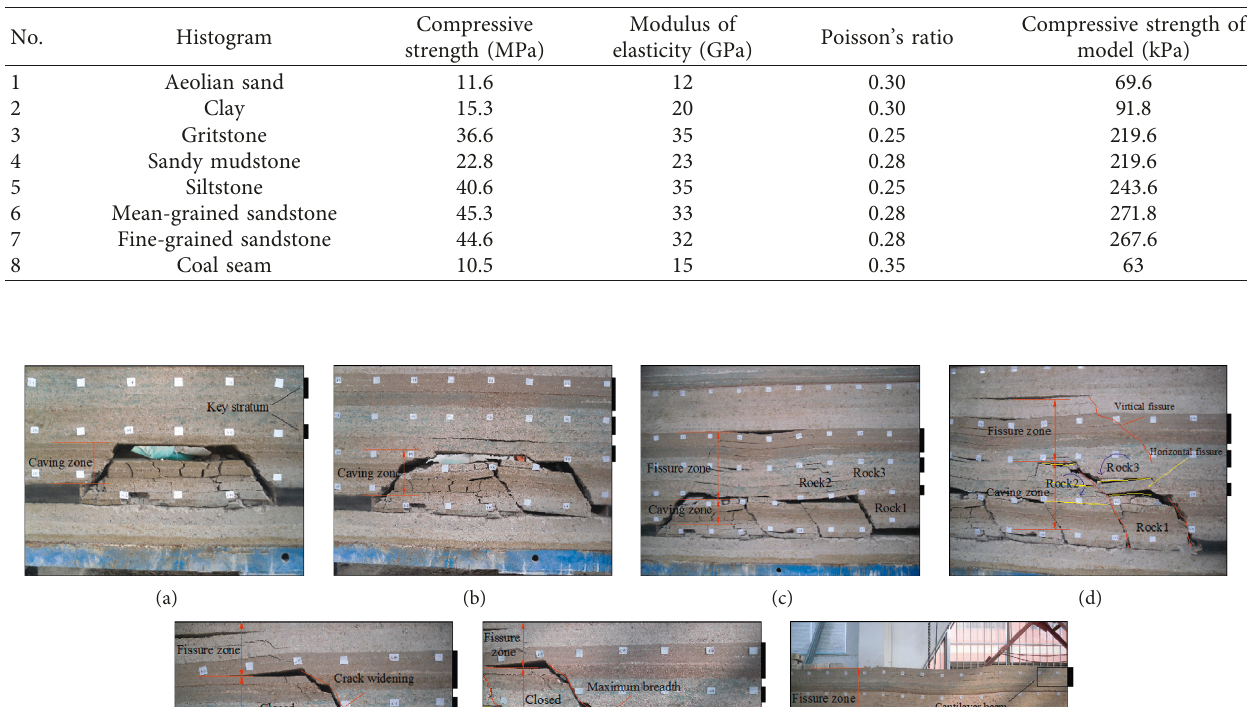
Table 1: Physical and mechanical parameters of the model.